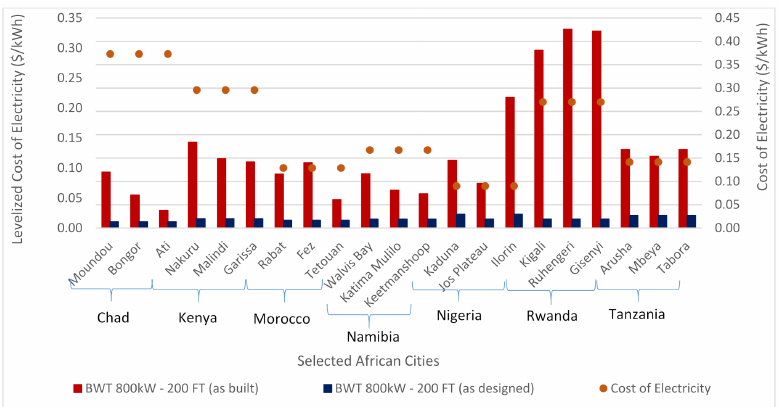
Figure 8. Annualized return on investment and Simple Payback period of the FWT in the selected African cities.